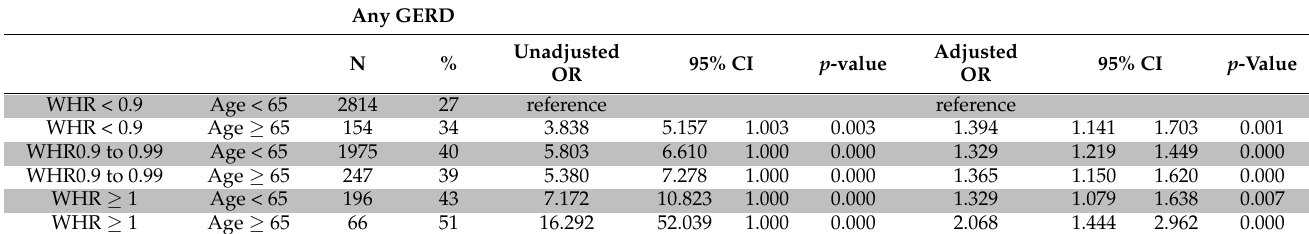
Table 4. Interaction of WHR and age with the risk of